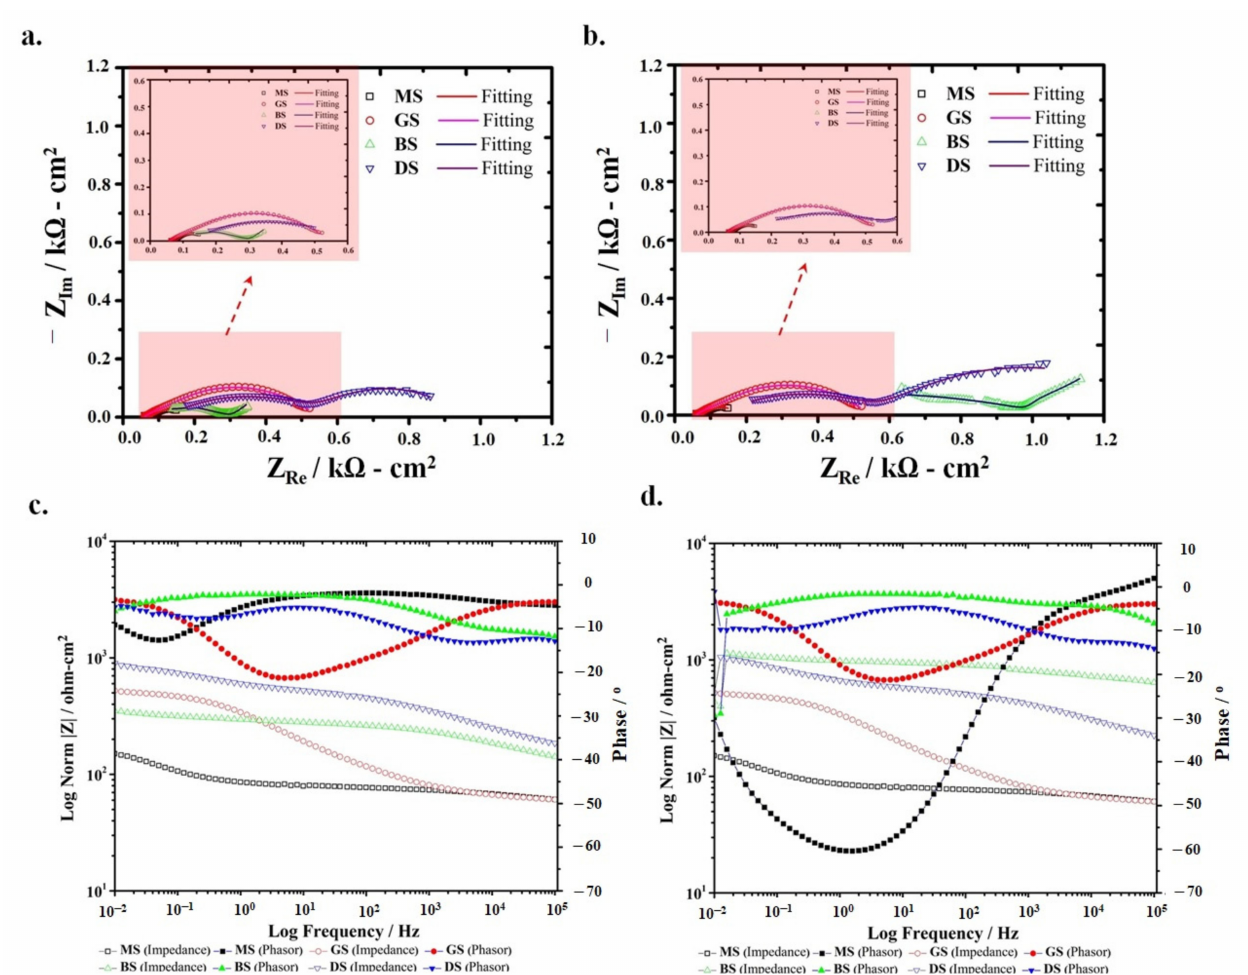
Figure 4. MS and Zn-coated samples in Soil Nyquist plots of after ( a ) one hour and ( b ) 24 h of exposure and Bode plots after ( c ) one hour and ( d ) 24 h of